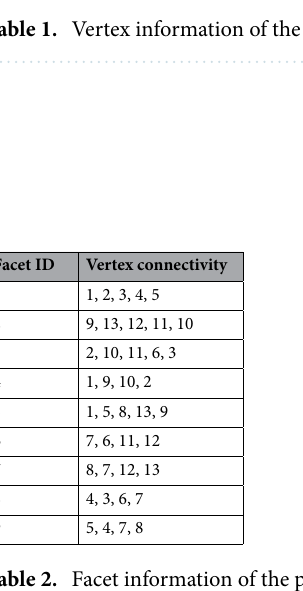
Table 2. Facet information of the